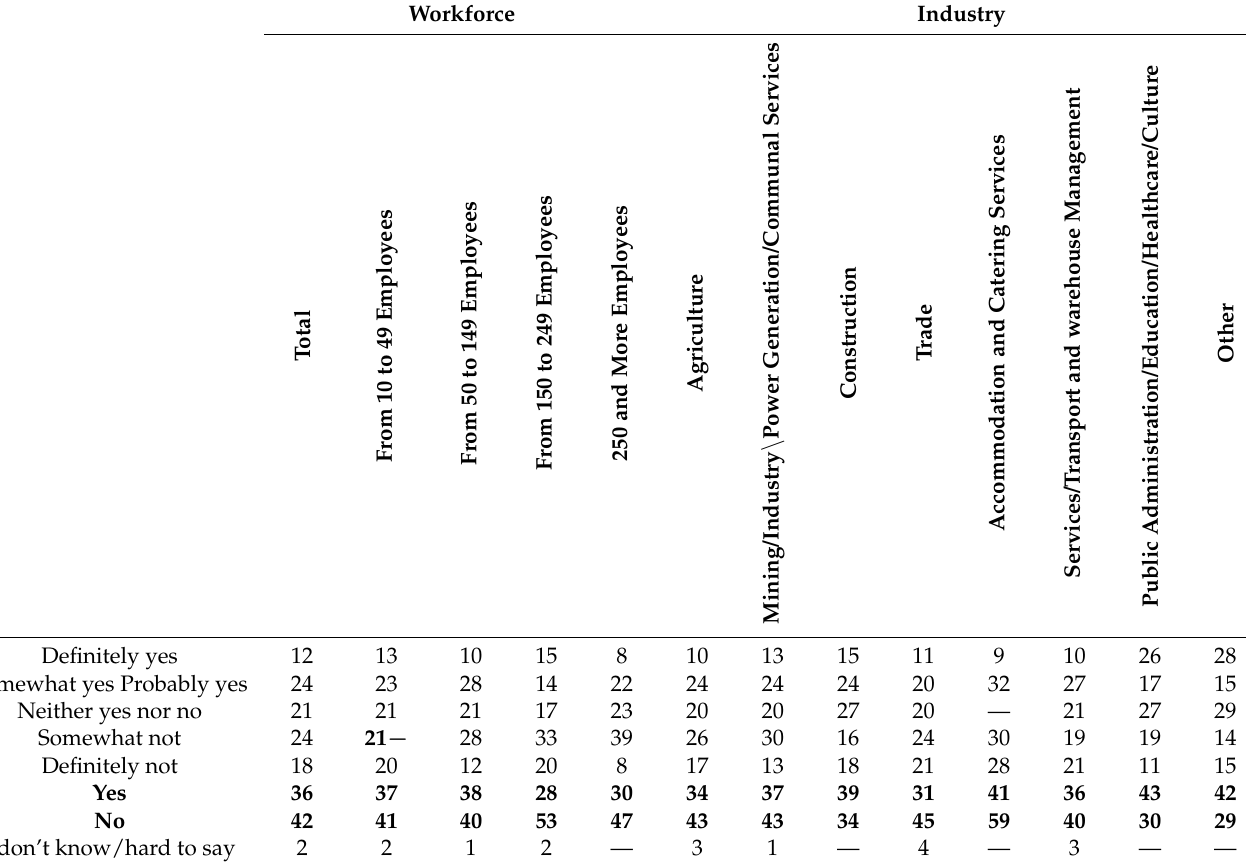
Table 7. EU climate policy assessed by entrepreneurs in Poland—by workforce and industry (answers in percentage points). Will the EU plans to reduce CO 2 to zero and make the European economy emission-free (i.e., the European Green Deal) ensure the competitiveness of the European